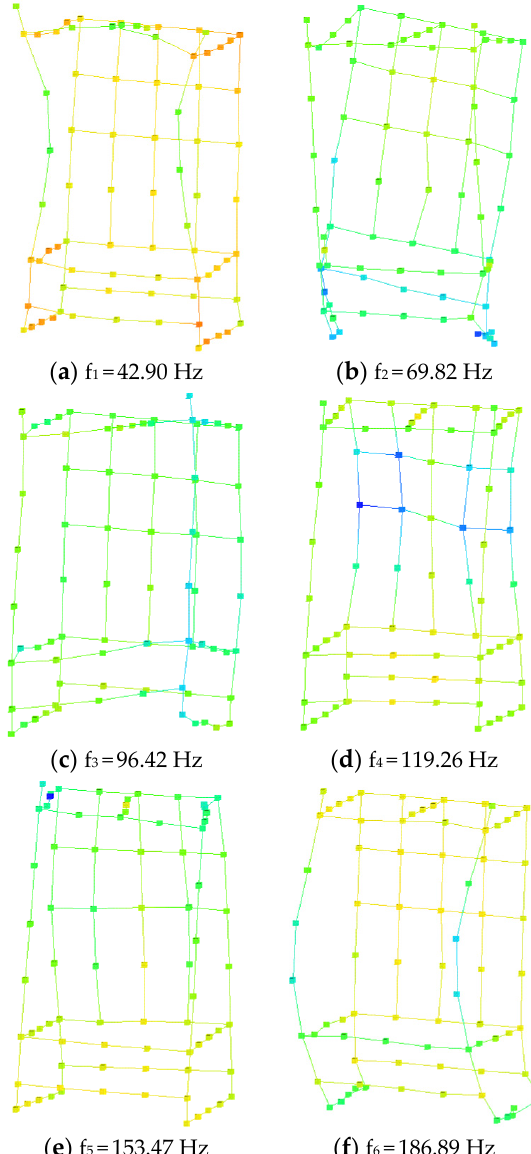
Figure 5. Free modal test results of the experiment rack simulator.